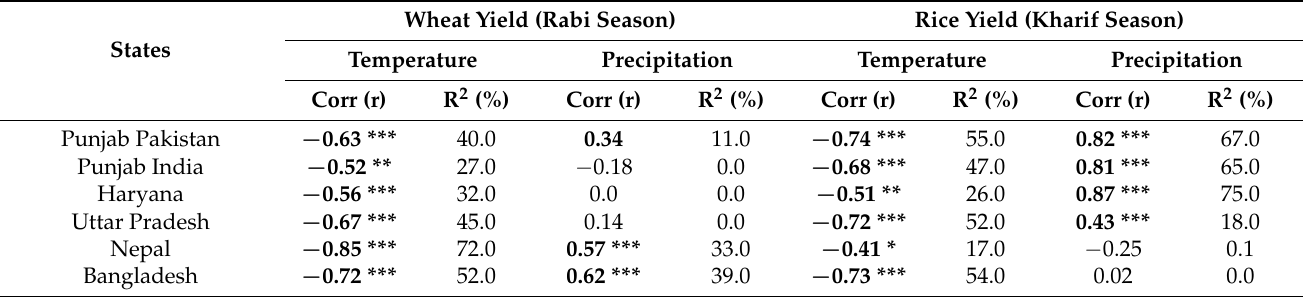
Table 5. Crop yield sensitivity to climate variables using LPJmL model simulated data over six study sites in the IGB river basins during the period 1981–2010. Bold numbers show the strong correlation, i.e., more than 0.30 between wheat and rice crop yields with climate variables and star shows the statistically significance